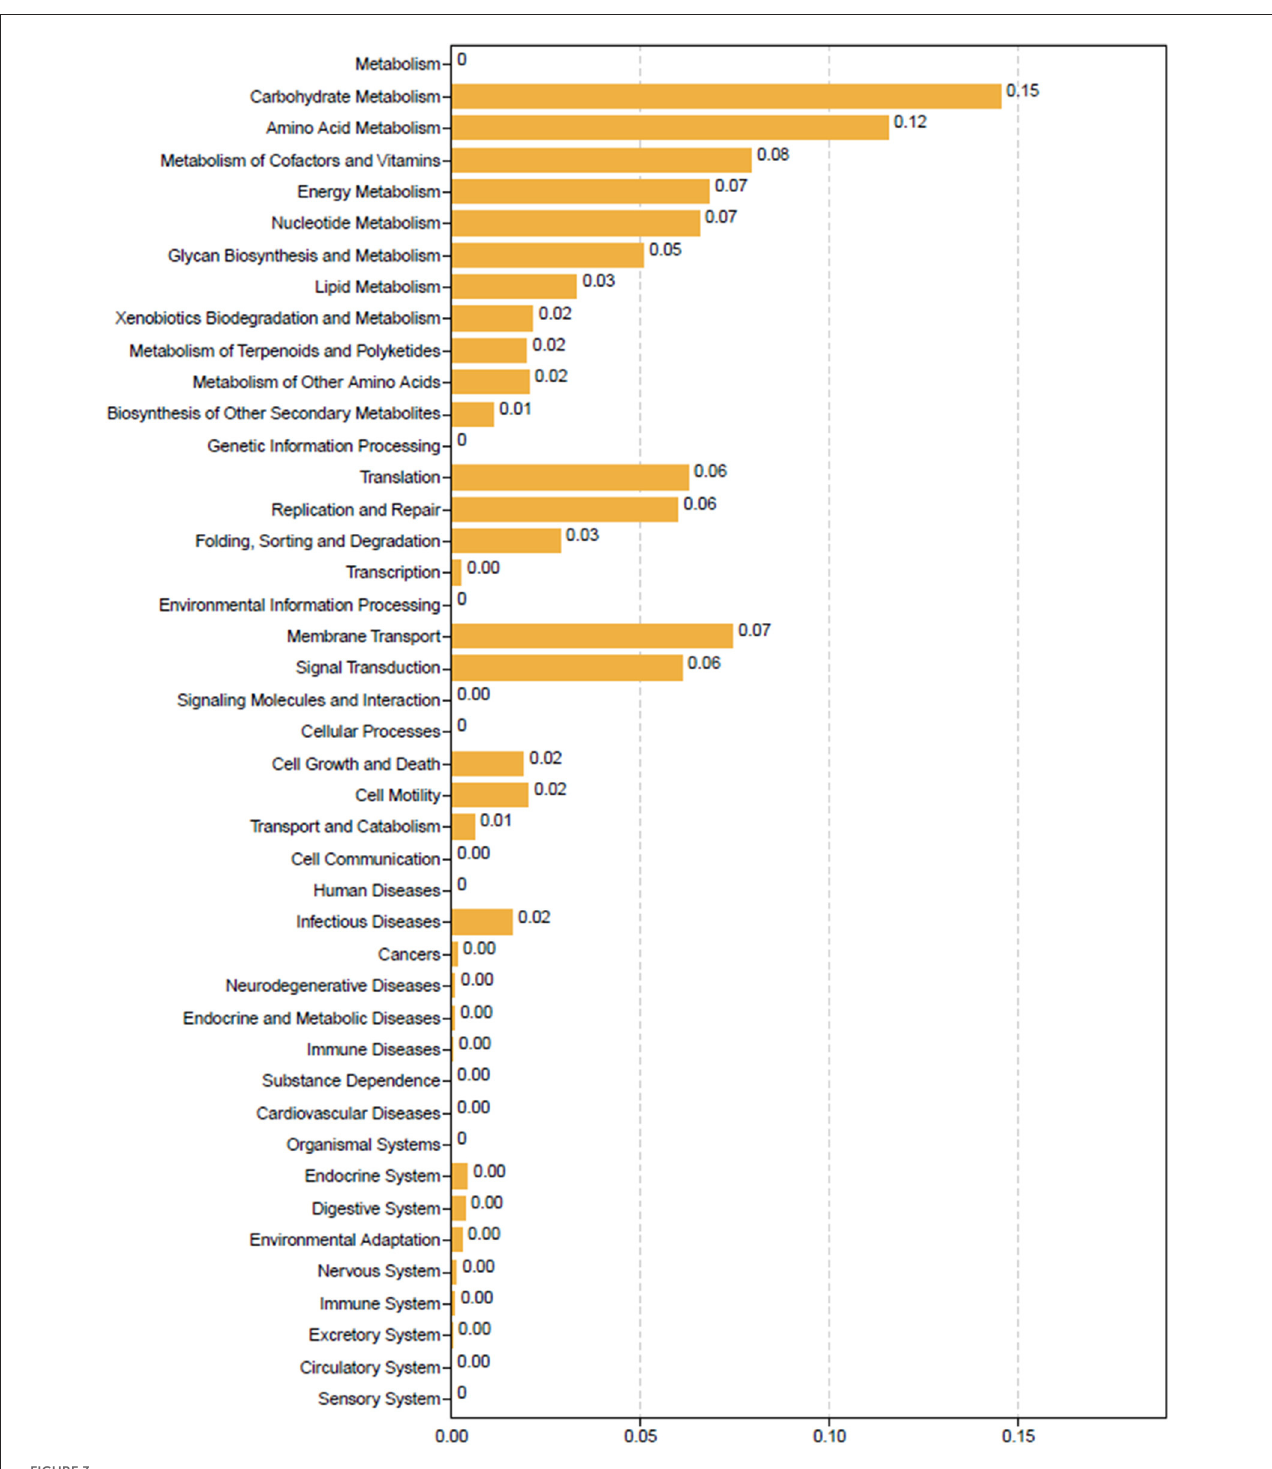
FIGURE3 Tax4Fun functional prediction analysis of the differential abundant bacterial communities between low-and high-residual feed intake